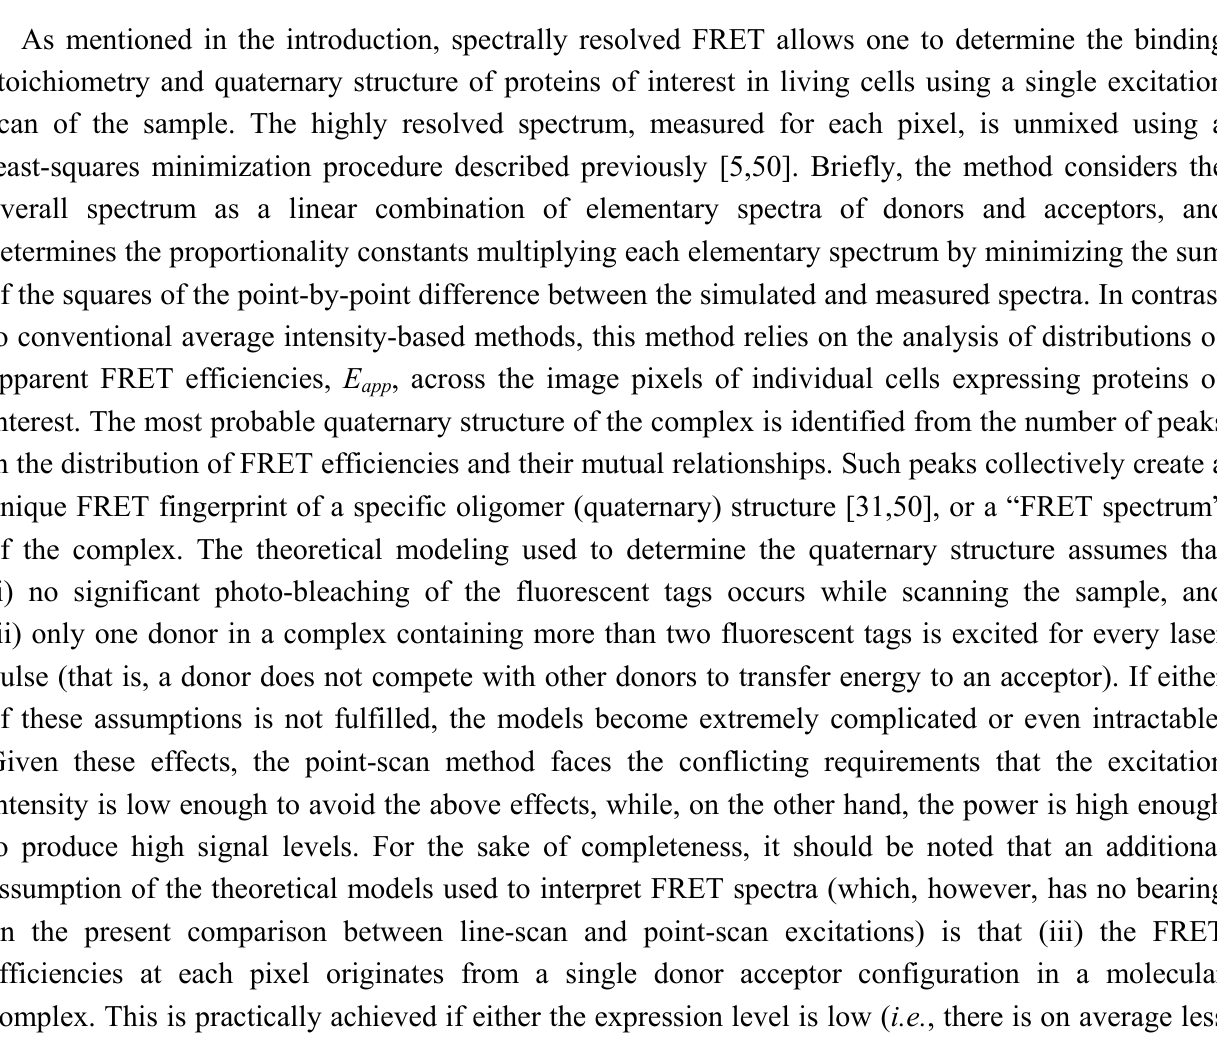
and PS = 29 ms for 300 pixels and LS